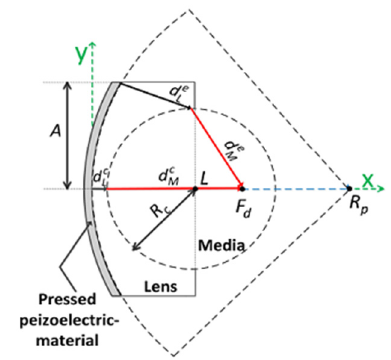
Figure 2. Schematic diagram to determine the radius of lens curvature for the proposed double-focused transducer.